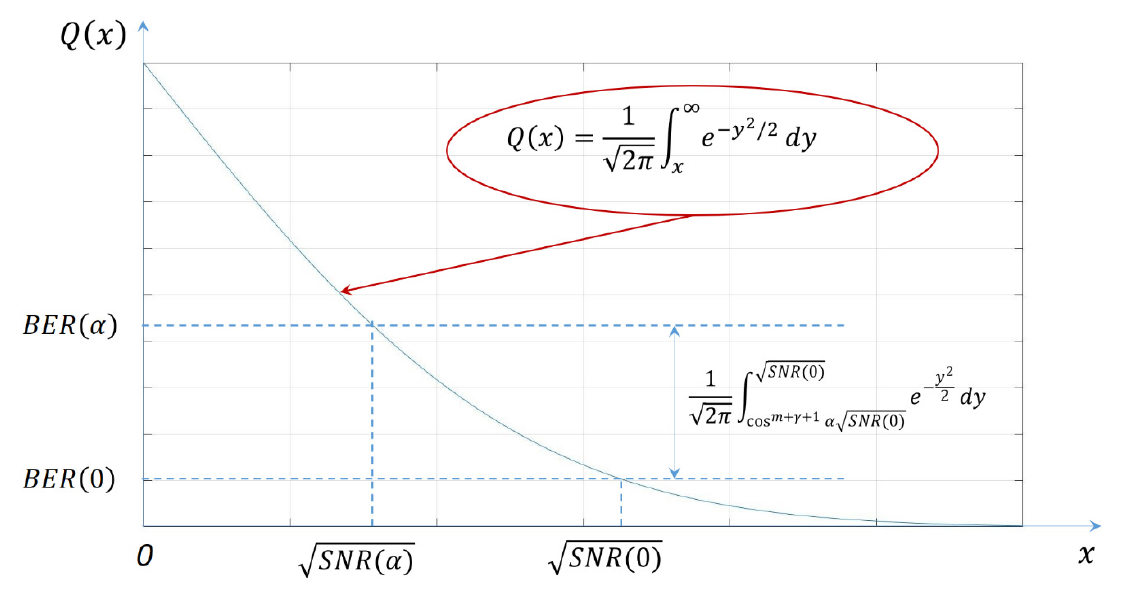
Figure 3. Bit Error Rate analysis.